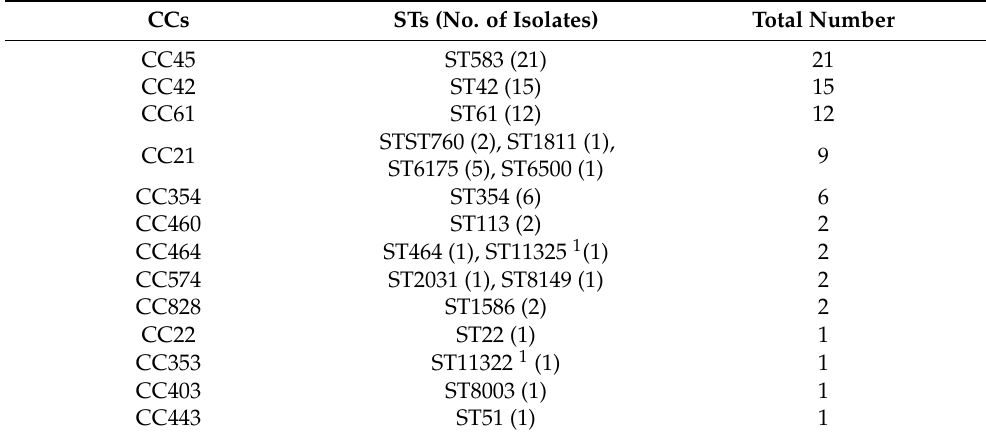
Table 1. Distribution of clonal complexes (CCs) and sequence types (STs) of 100 C. jejuni isolates from poultry